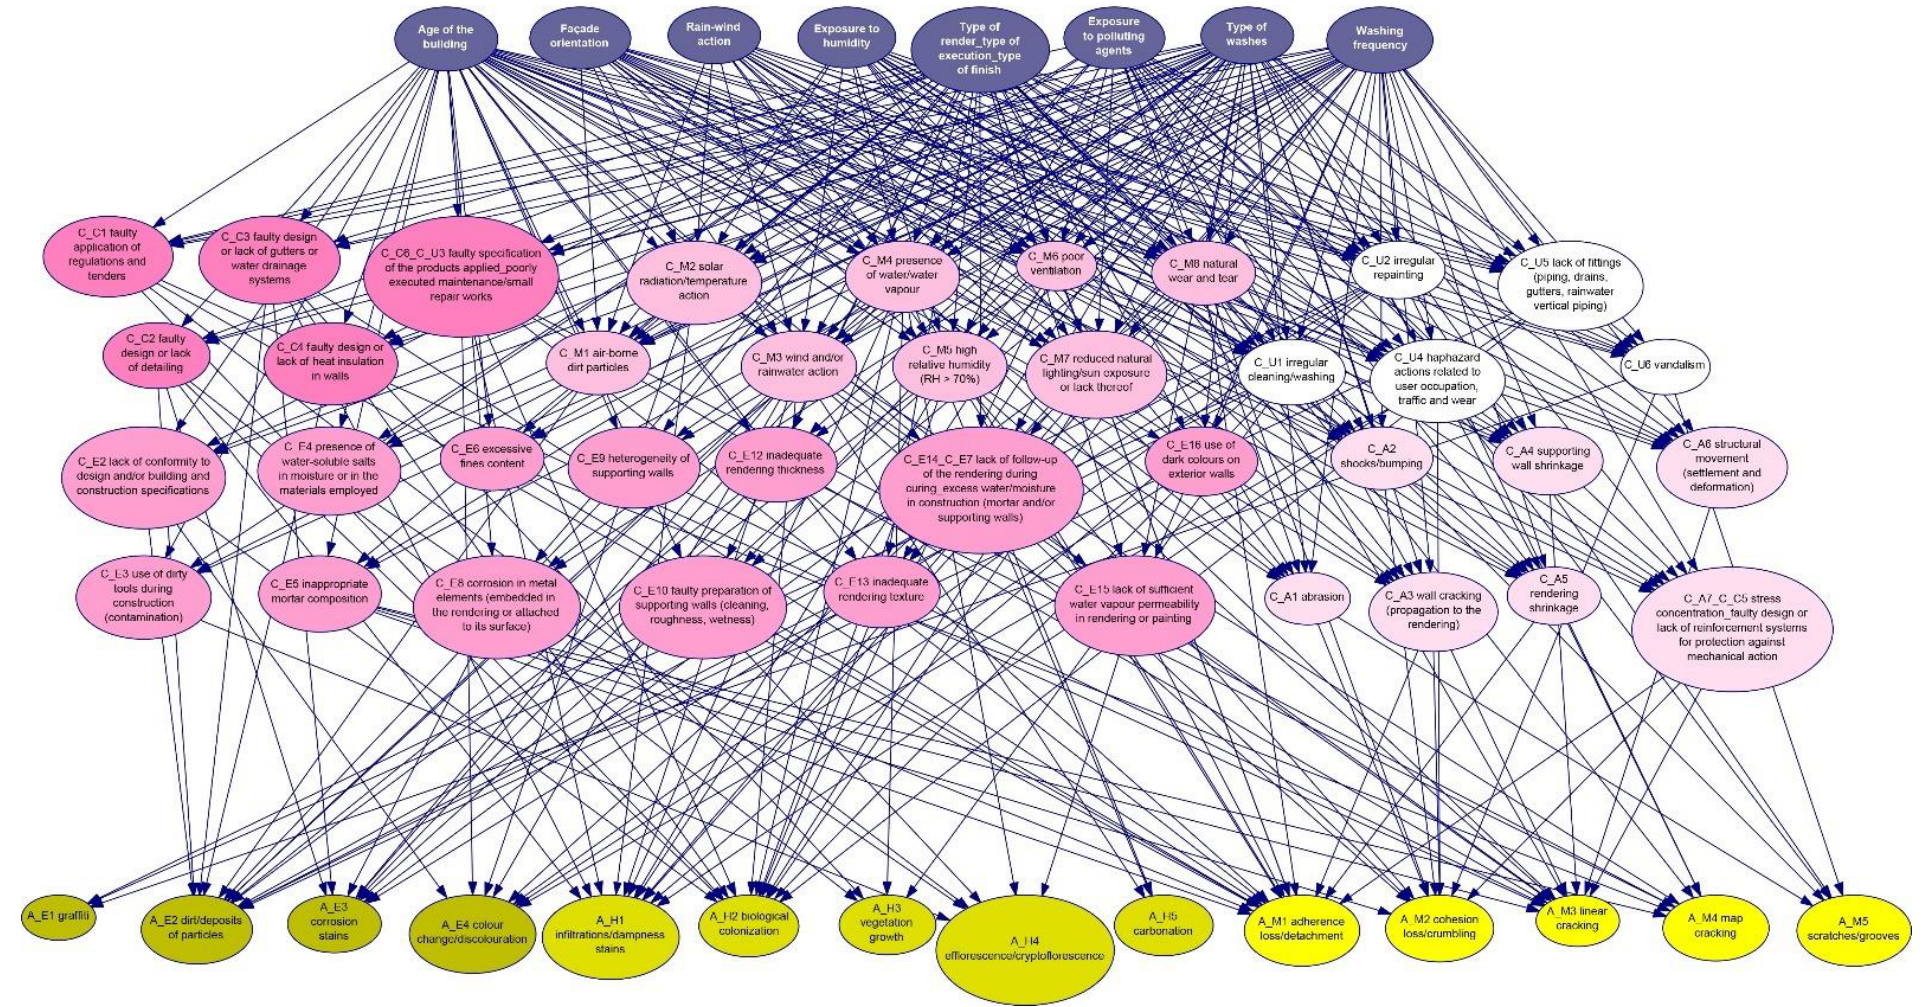
Figure 2. BN model to quantify uncertainty in building diagnosis.